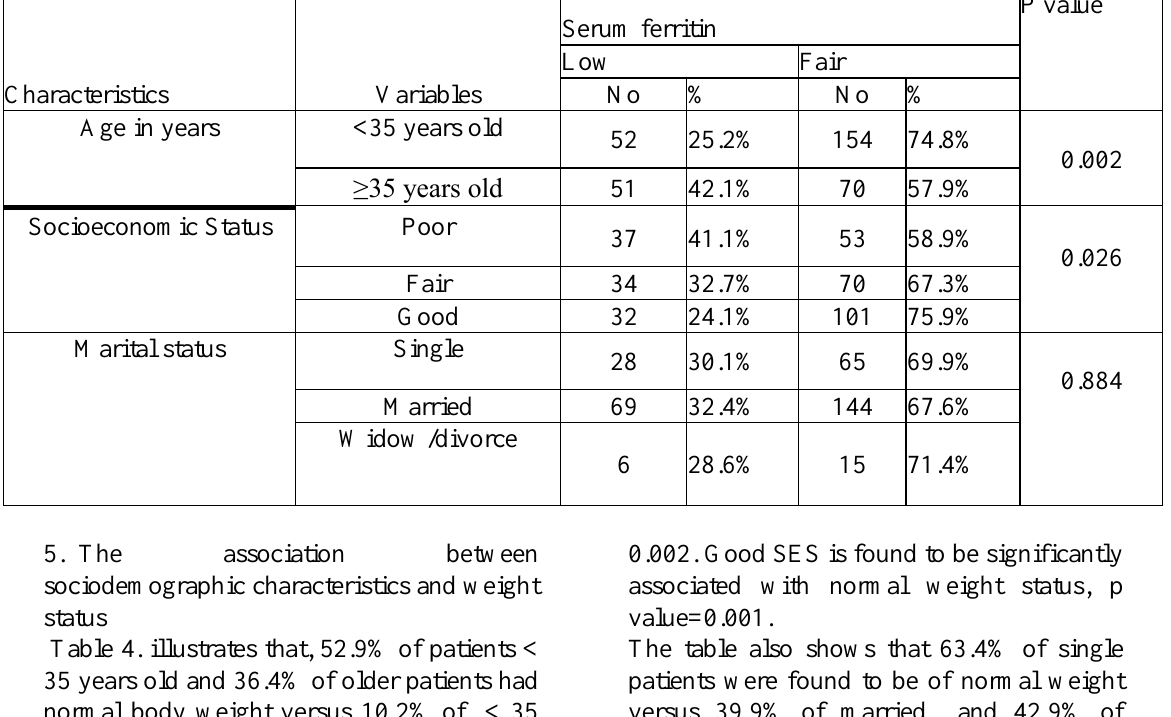
Table 3. The association between sociodemographic characteristics and SFL among CTE patients